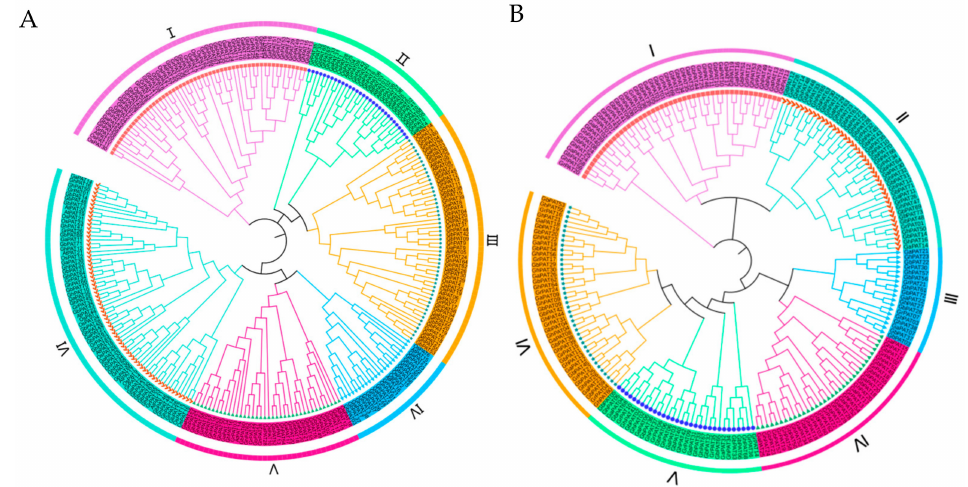
Figure 2. Relationships between phylogenies of PAT family gene members in plants. ( A ) Phylogenetic relationships of PAT family genes in Arabidopsis, rice, G. arboreum , G. raimondii , G. barbadense and G. hirsutum ; ( B ) Phylogenetic relationships of PAT genes in G. arboreum , G. raimondii , G. barbadense and G. hirsutum